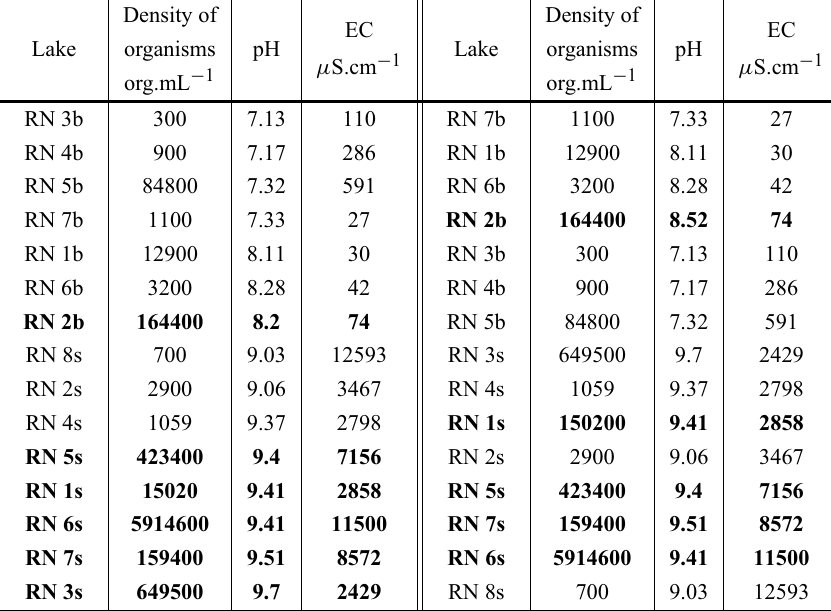
Density of organisms, EC and pH of the August 2007 sampling. The data are ordered by pH on the left and by EC on the right. The highest pHs are related to the highest density of organisms, and there is a greater independence from EC. The data showing the higher density of organisms, pH and EC are in bold characters. Density of Density of EC EC Lake organisms